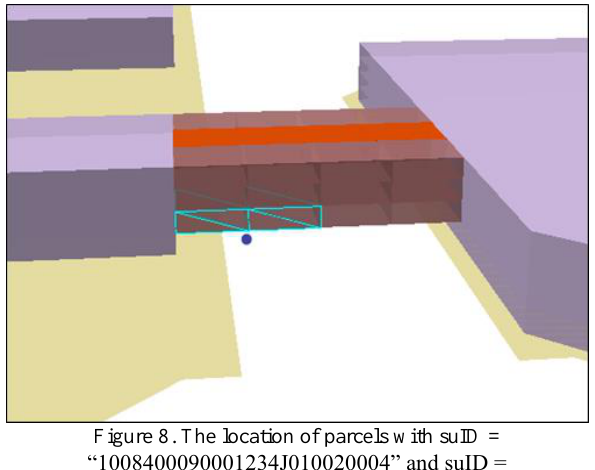
Figure 8. The location of parcels with suID